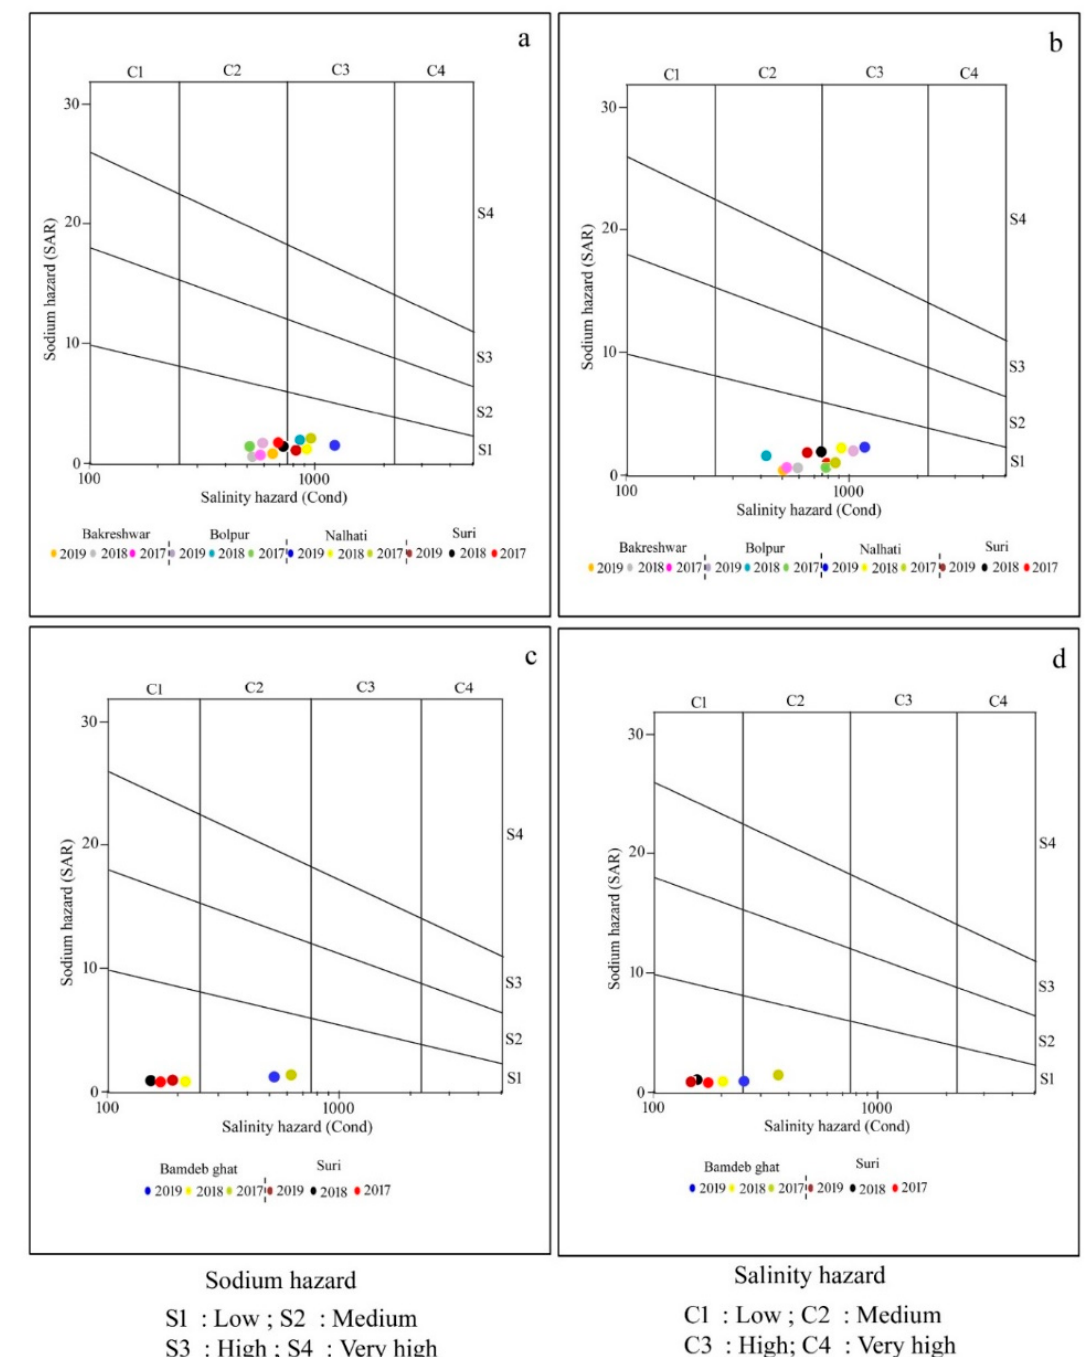
Figure 3. USSL classification of surface and groundwater samples for irrigation: ( a ) groundwater samples of pre-mon season; ( b ) groundwater samples of post-mon season; ( c ) surface water samples of pre-mon season; ( d ) surface water samples of post-mon season.